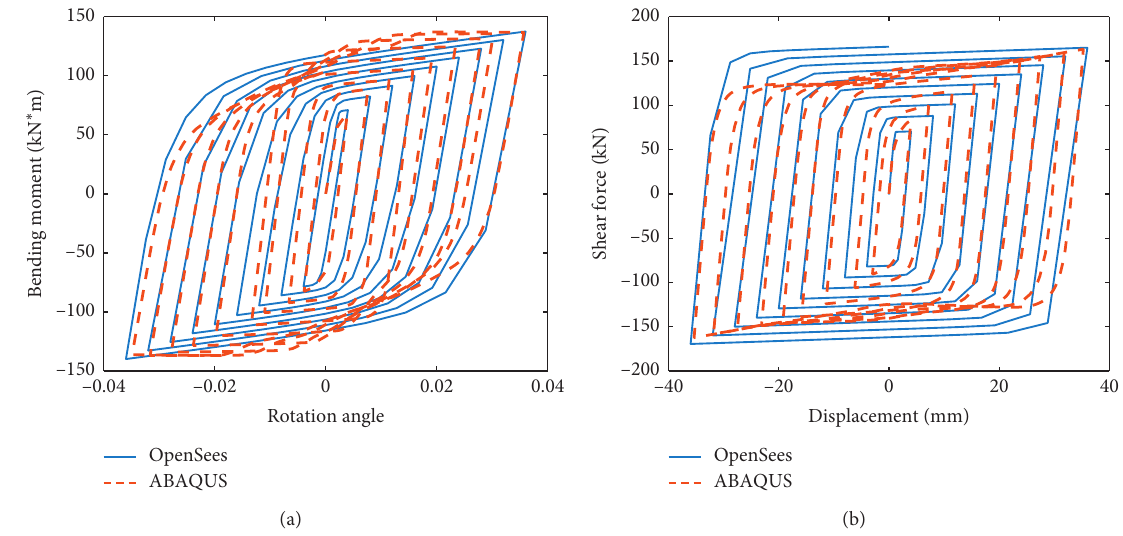
Figure 11: Comparison of ABAQUS FE simulation results and OPENSEES parameters fitting. (a) Hysteretic curves of loading in bending direction. (b) Hysteretic curves of loading in shear